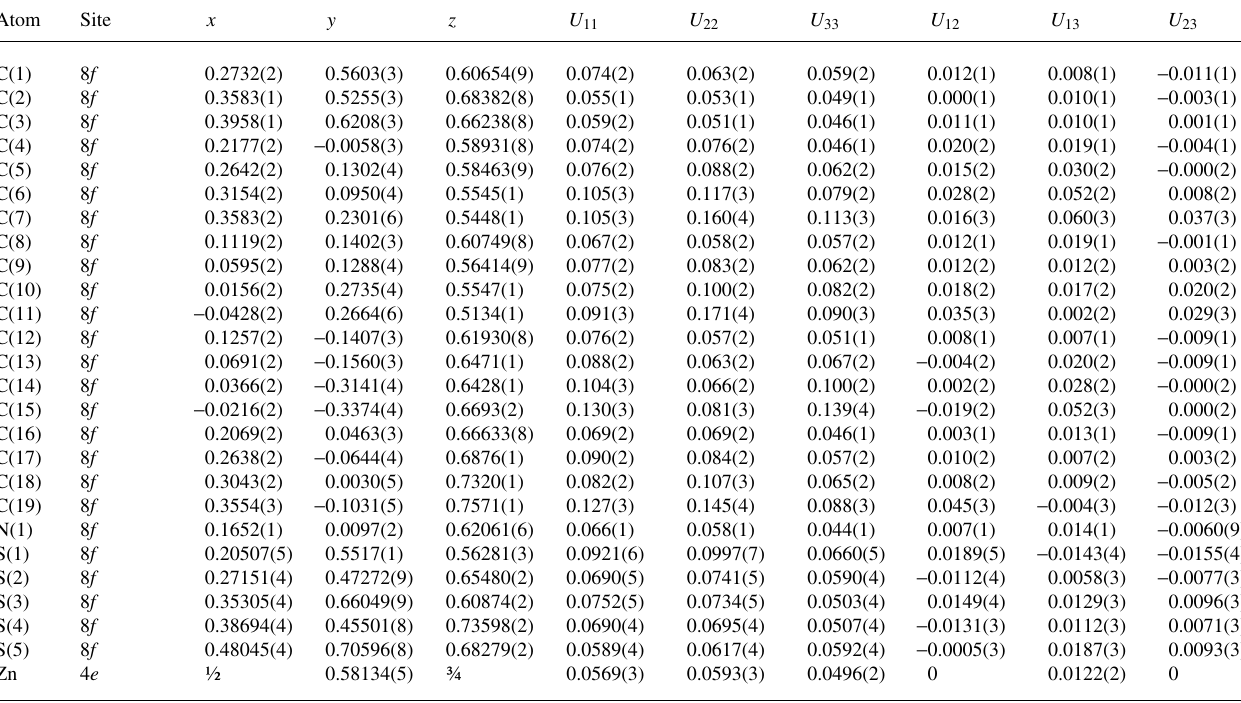
Table 3. Atomic coordinates and displacement parameters (in Å 2 ) .